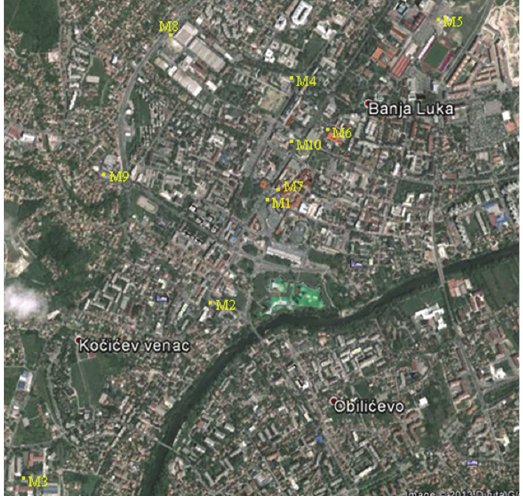
Figure 15: Points of total electric field strength maximums in the wider city centre of Banja